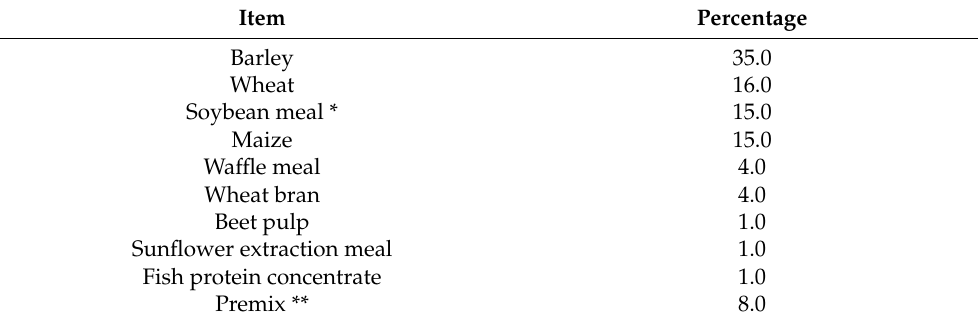
Table 1. Composition (%) of the of the basis feed for the experimental